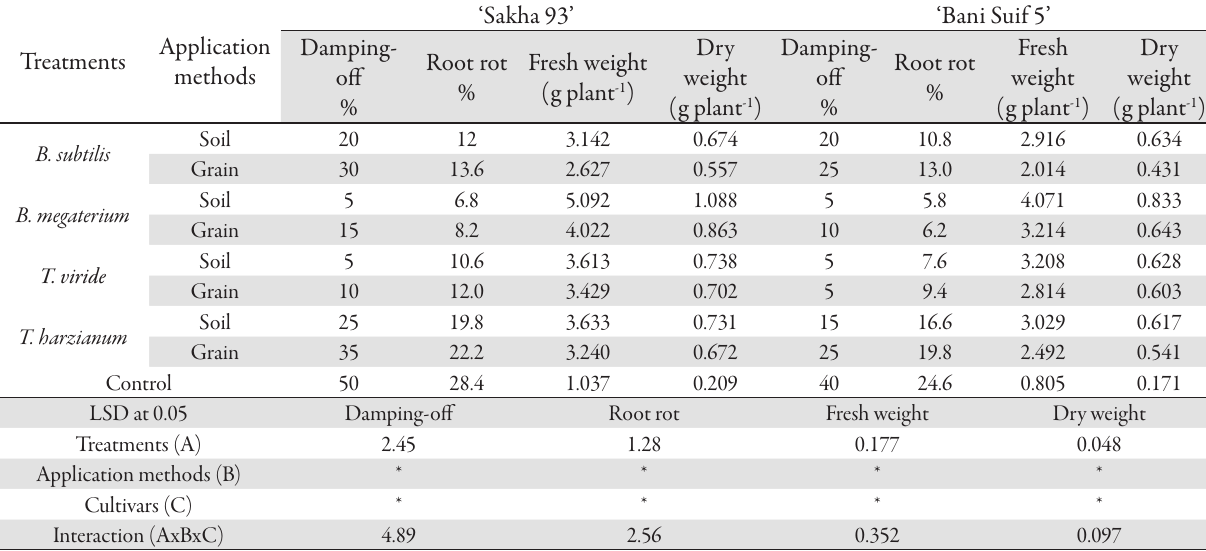
Tab. 4B. Effect of soil drenching, wheat grain treatment with different bioagents on damping-off and root rot diseases, fresh and dry weight plant -1 under artificial infection with Drechslera halodes under greenhouse conditions